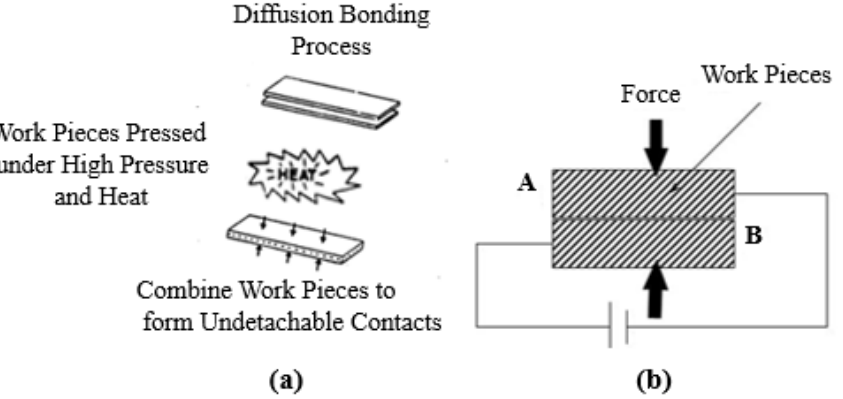
Figure 1. Schematic of diffusion welding process ( a ) Bonding of two wafers under high pressure and temperature; ( b ) Direct bonding of wafers A and B under high pressure [25].